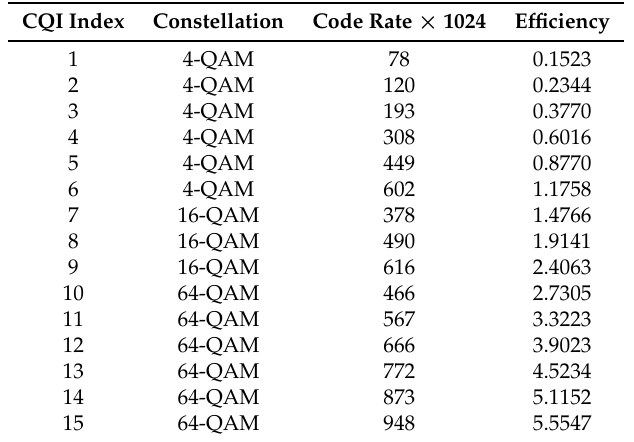
Table 1. Possible combinations of coding rates and modulation orders ( CQI! s) used in the digital